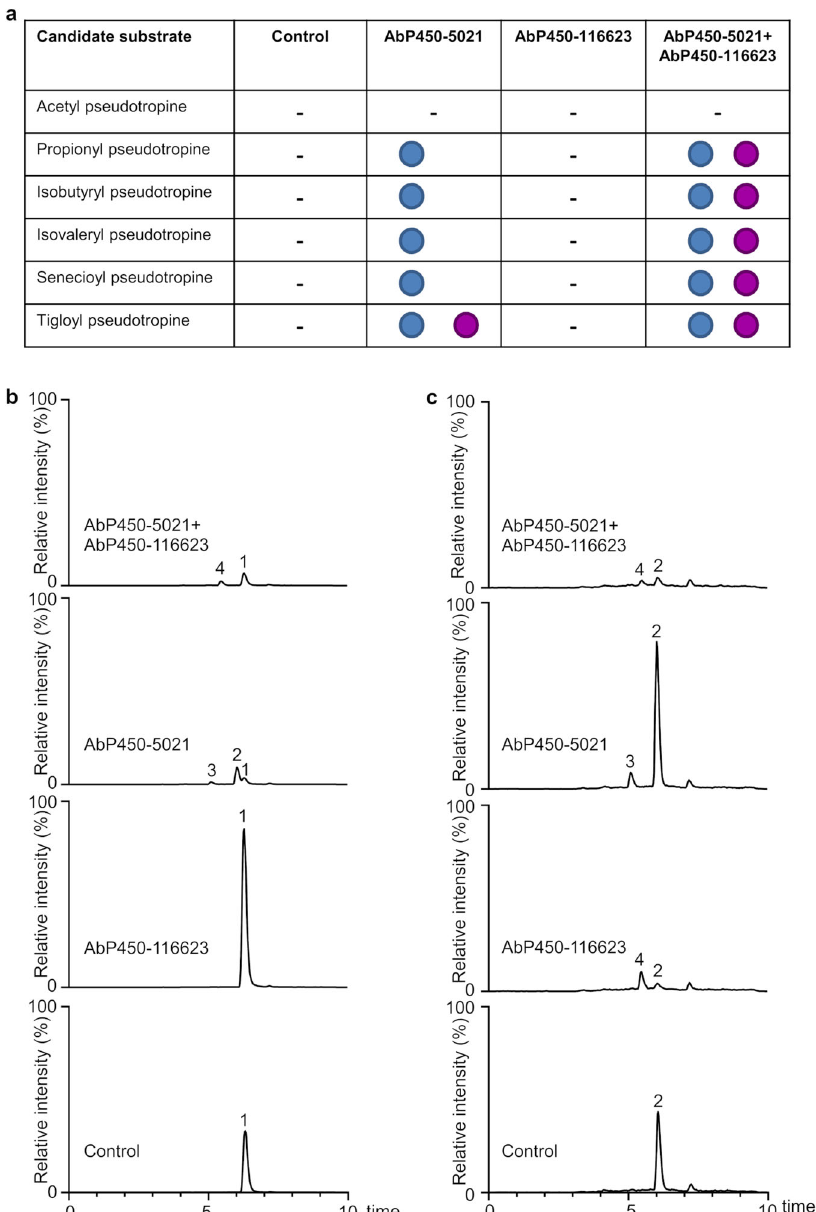
Fig. 3 N. benthamiana transient assays with short-chain O -acyl pseudotropines. N. benthamiana leaves producing AbP450-5021, AbP450-116623 or AbP450-5021 + AbP450-116623 were assayed with short-chain O -acyl pseudotropine esters for N -demethylase and ring-hydroxylase activity ( a ) (-, no products detected; blue circle, N -demethylase product O -acyl norpseudotropine; purple circle, ring-hydroxylase product O -acyl hydroxynorpseudotropine). Control experiments were conducted with in fi ltrated leaves that did not produce A. belladonna cytochrome P450s. Leaf metabolite extracts were analyzed by UHPLC/MS using a 10-min gradient elution method (Supplementary Data 3 and 4). Each condition was tested in triplicate, and the experiments were replicated twice. Representative chromatograms are shown for assays with N -methylated tigloyl pseudotropine ( b ) and N -demethylated tigloyl norpseudotropine ( c ). Each chromatogram represents a combined extracted ion chromatogram for the exact masses of tigloyl pseudotropine (1), tigloyl norpseudotropine (2), tigloyl hydroxynorpseudotropine isomer 2 (3) and tigloyl hydroxynorpseudotropine isomer 1 (4). Note the absolute vertical scale (y- axis) is identical for each set of chromatograms shown in b , c alone did not yield demethylated products with any of the N - methylated candidate substrates tested (Fig. 3, Supplementary Figs. 6 – 10, Supplementary Data 3 and 4). In leaves producing AbP450-5021 + AbP450-116623, short-chain O -acyl pseudotro- pine substrates with acyl chain lengths of three to fi ve carbon atoms were consumed and, depending on the substrate used, products matching the respective N -demethylated short-chain O - acyl hydroxynorpseudotropine esters accumulated (Fig. 3, Supple- mentary Figs. 6 – 10, Supplementary Data 3 and 4). Hydroxylated